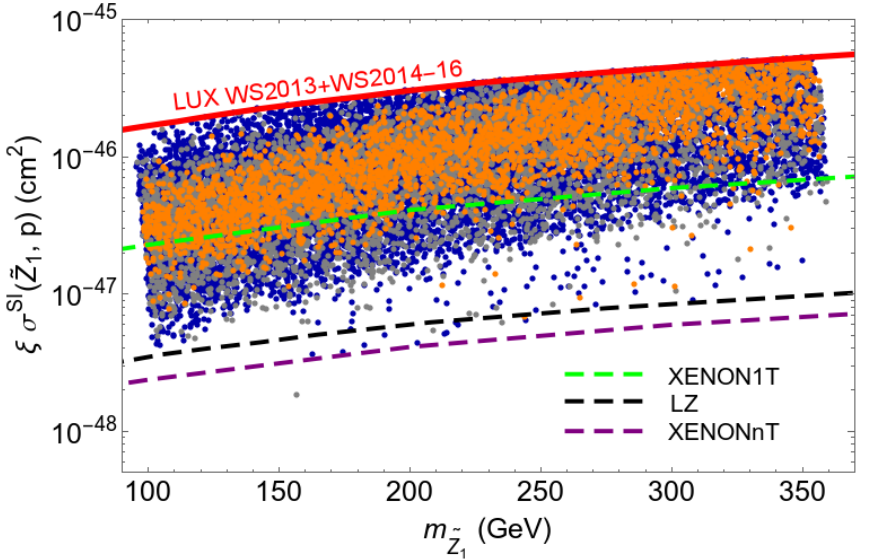
Figure 17 . A scatter plot of (cid:24)(cid:27) SI ( e Z 1 ; p ) versus m for solutions with (cid:1) EW < 30 from the same e Z 1 three scans over the natural mini-landscape parameter space with m 0 (1 ; 2) ’ (2 ; 1 ; 1 = 2) (cid:2) m 3 = 2 illustrated in (cid:12)gure 10. Here (cid:24) is the higgsino fraction of the total CDM density, assuming that the relic density of higgsino WIMPs is given by its thermal value. The colour scheme in this (cid:12)gure is the same as in (cid:12)gure